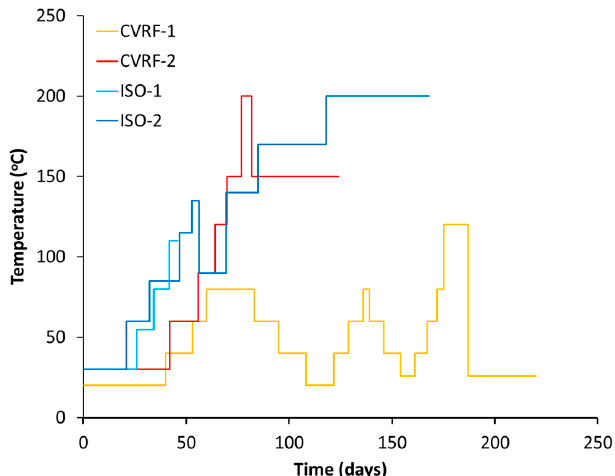
Figure 4. Temperature increments throughout the four experiments. During each experiment, the temperature of the pressure vessel fluctuated by ±3 degrees of the given value.